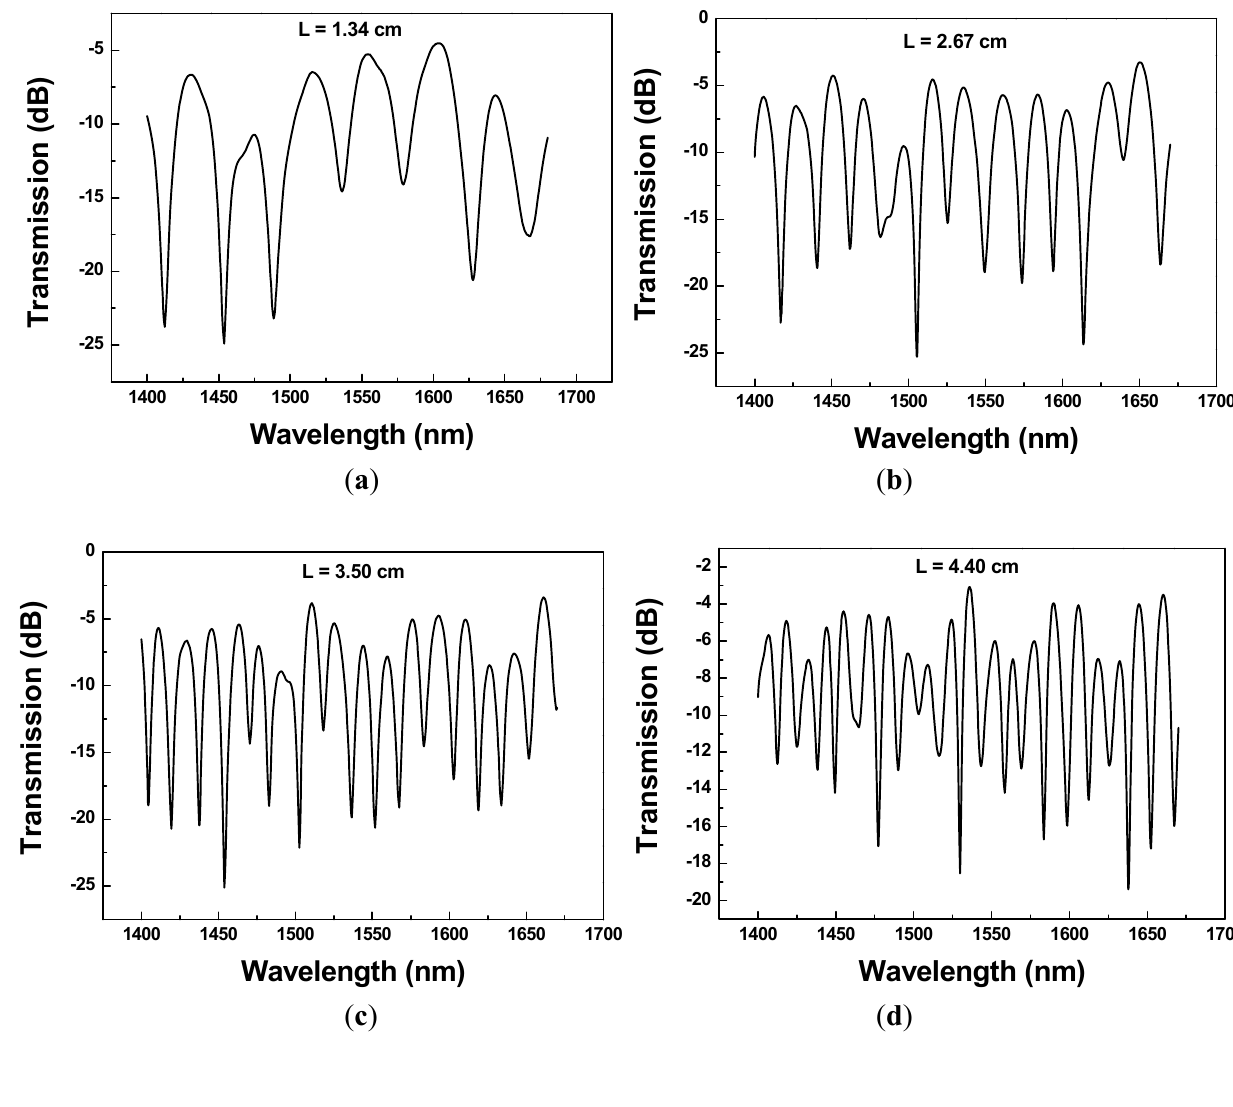
Figure 5. ( a–e ) The transmission spectra of the PCF interferometers with several sensing lengths; ( f ) Plot of fringe period as a function of sensing